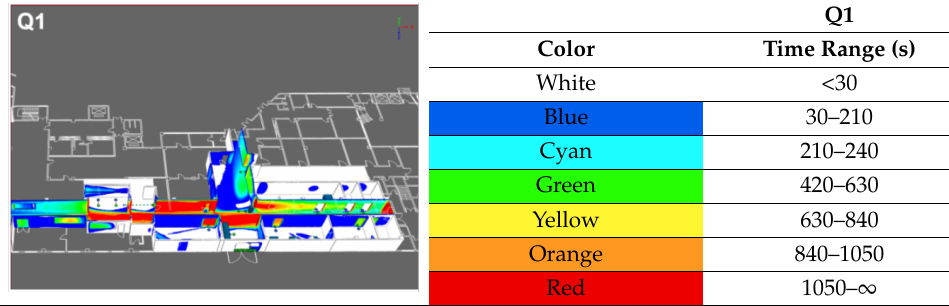
Table 3. Vision time map analysis in